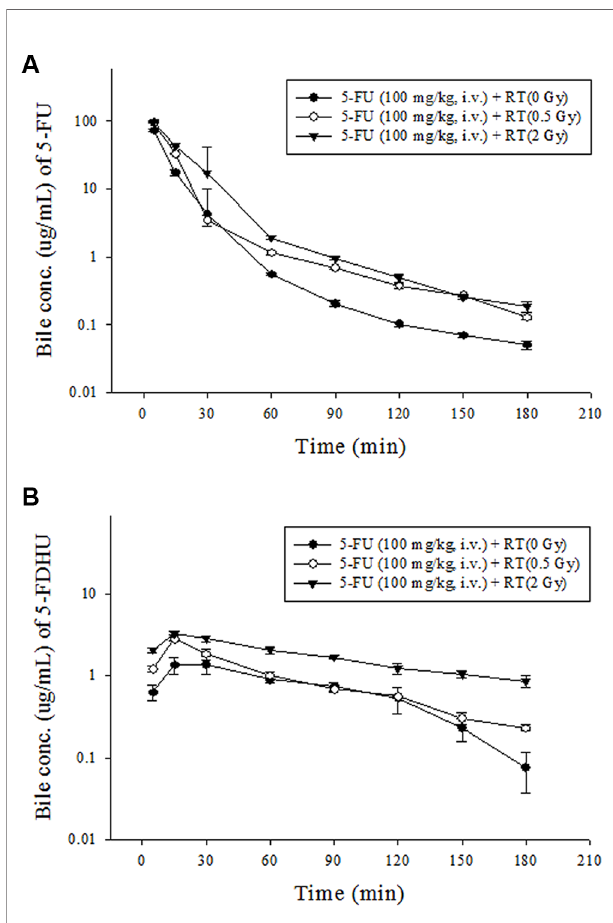
FIGURE 4 | (A) Mean bile concentration-time curves of 5-FDHU ( (cid:129) ) in rat bile after 5-FU administration (100 mg/kg, iv) alone, 5-FU (100 mg/kg, i.v.) + RT (0.5 Gy) ( ○ ) and 5-FU (100 mg/kg, i.v.) + RT(2 Gy) ( ▼ ). (B) Mean bile concentration-time curves of 5-FDHU ( (cid:129) ) in rat bile after 5-FU administration (100 mg/kg, iv) alone, 5-FU (100 mg/kg, i.v.) + RT (0.5 Gy) ( ○ ) and 5-FU (100 mg/kg, i.v.) + RT(2 Gy) ( ▼ ). (n = 6).